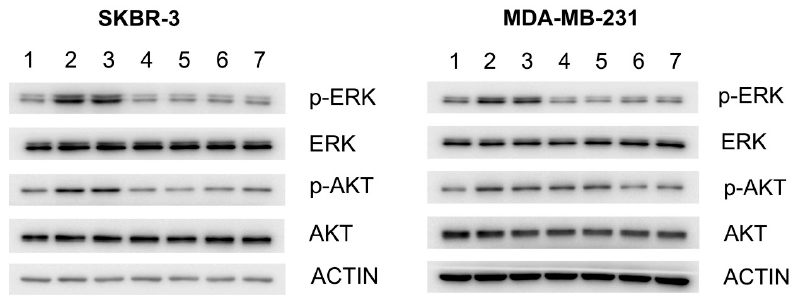
Figure 2. Effect of G7-peptides on ERK and AKT Signaling in ( left ) SKBR-3 and ( right ) MDA-MB-231 cell lines. (lane 1, non-stimulated; lane 2, FN; lane 3, FN + Pen; lane 4, FN + G7-B7-Pen; lane 5, FN + G7-B7M2-Pen; lane 6, FN + G7-M2-Pen; lane7, FN + G7-18NATE-Pen). β -Actin was used as a loading control. The results shown are representative of three independent experiments. FN = fibronectin.